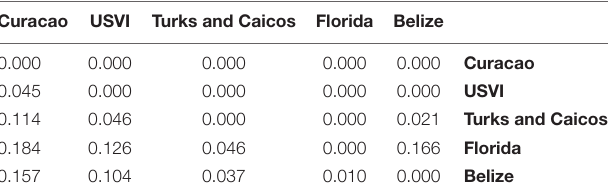
TABLE 2 | Pairwise F ST values between Dendrogyra cylindrus samples from five Caribbean regions (below